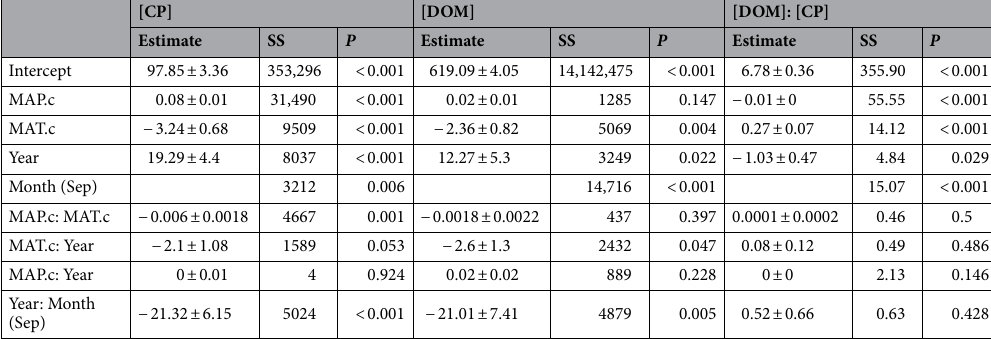
Table 2. Model results for comparing dietary quality for June and September between 2018 and 2019.